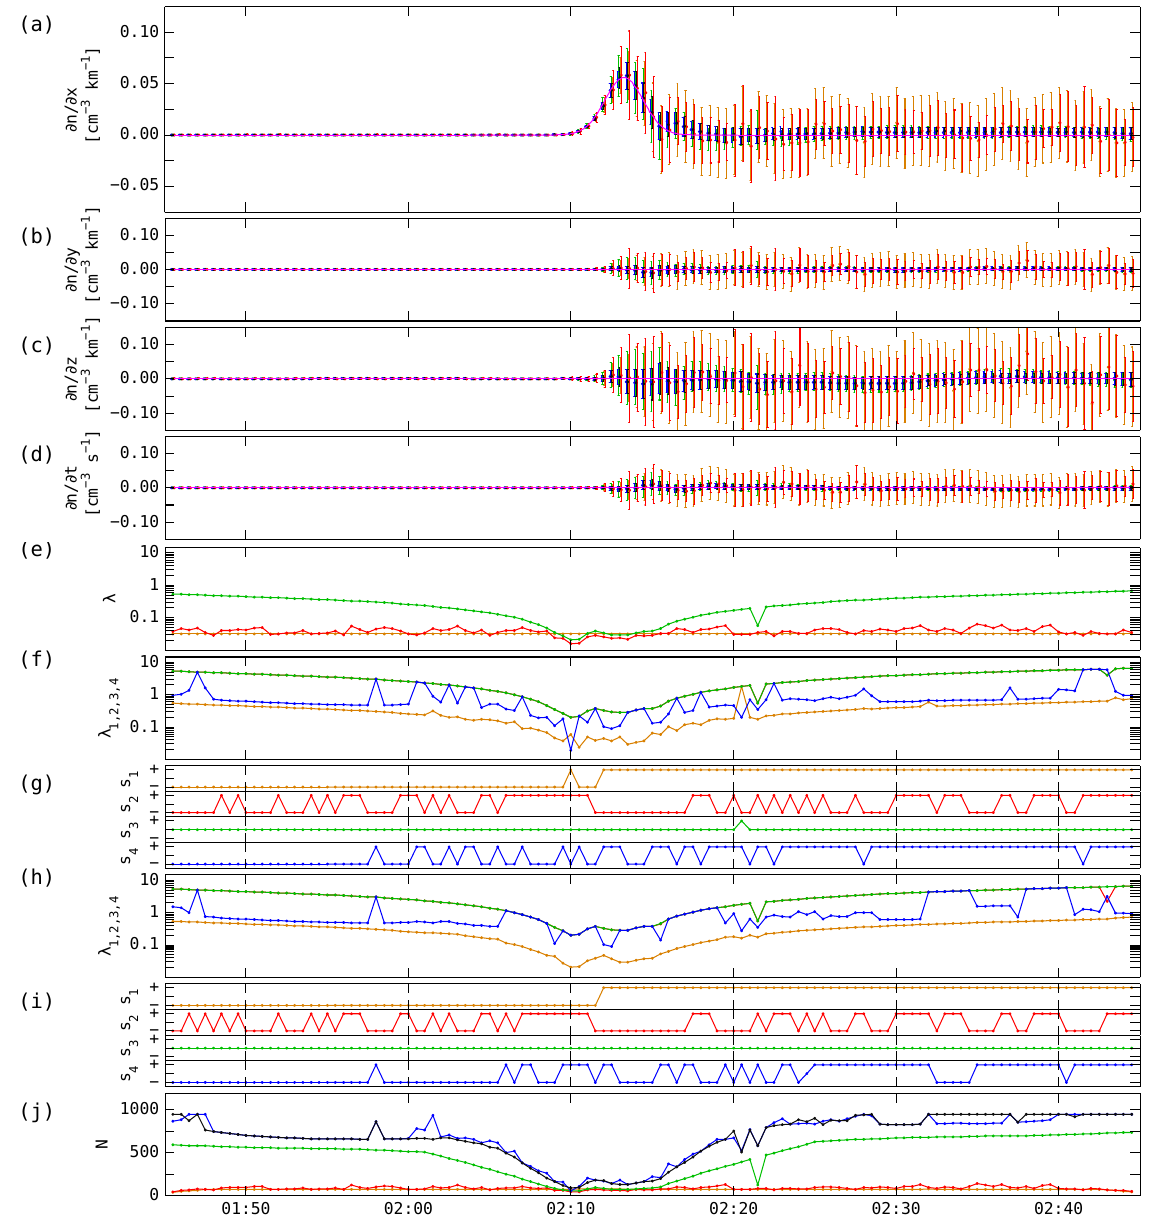
Fig. 8. Least-squares gradient at a density interface (4 spacecraft, small separation, 20% measurement error, smoothed at a 30s time